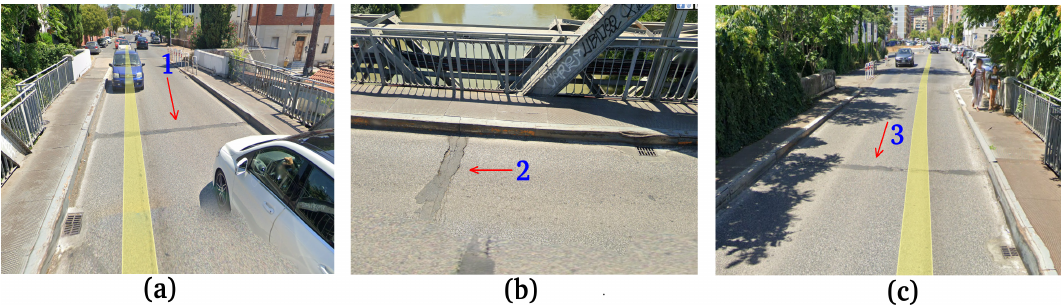
Figure 5. Optical representation of dilatation joints: ( a ) Joint number 1, ( b ) Joint number 2, ( c ) Joint number 3.